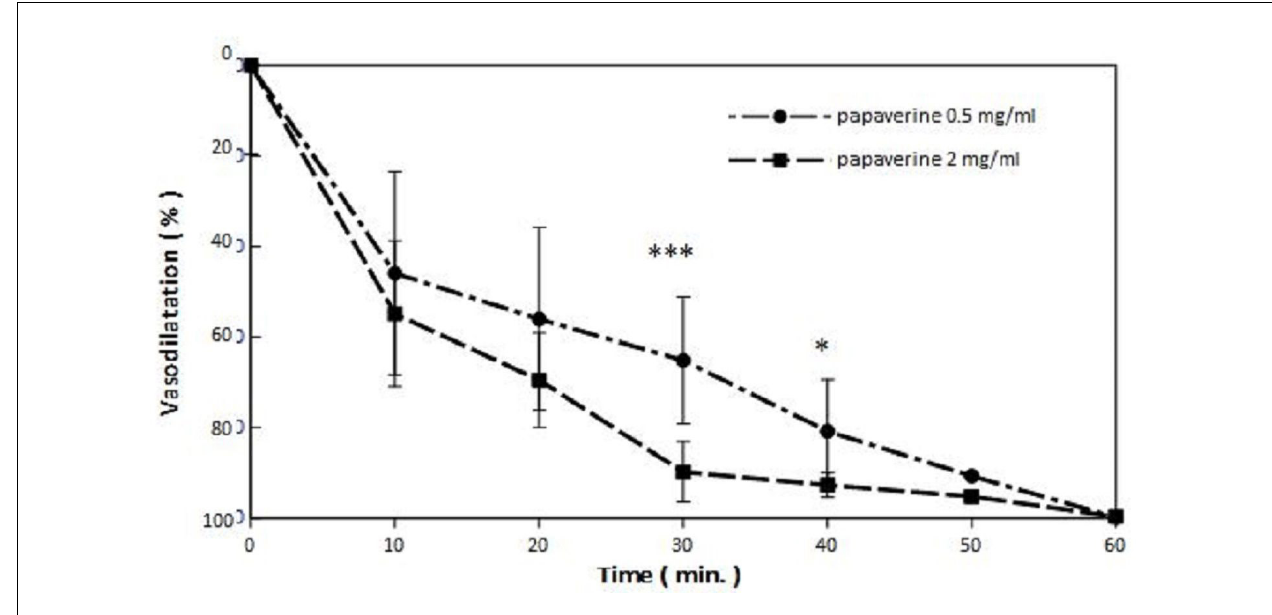
Fig. 1 – Vasodilatation of potassium chloride (KCl) precontracted radial artery segments induced by papaverine 0.5 mg/ml (n=12) and 2 mg/ ml (n=12). Mean±SD. ***P<0.001; SD=standard